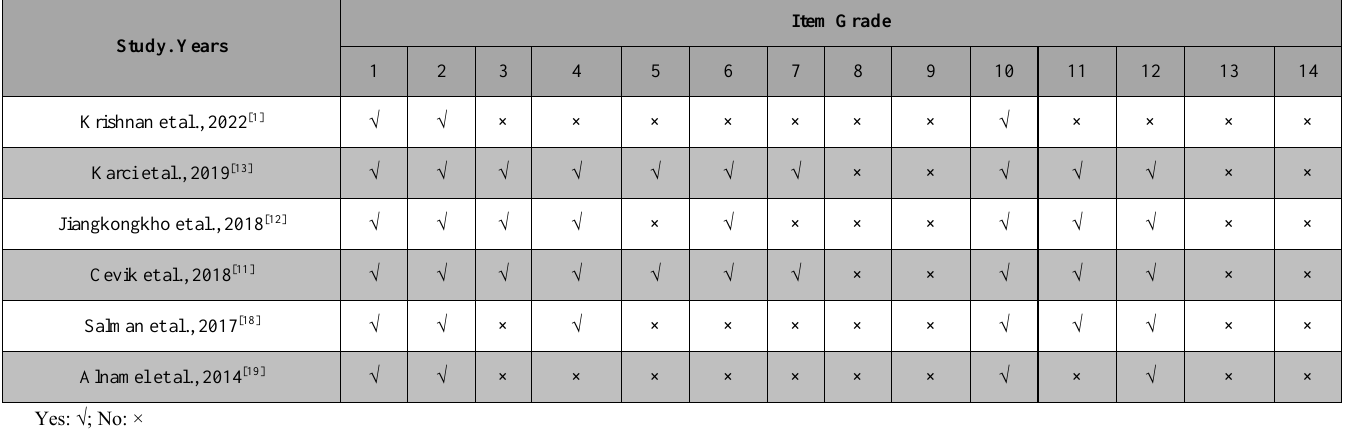
Table 3. Quality of the included studies.